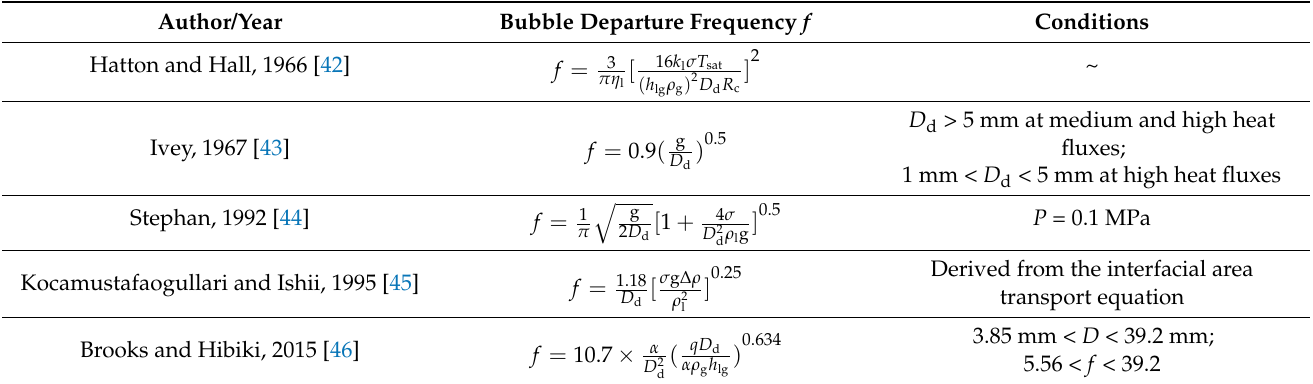
Table 4. Typical models of bubble departure frequency